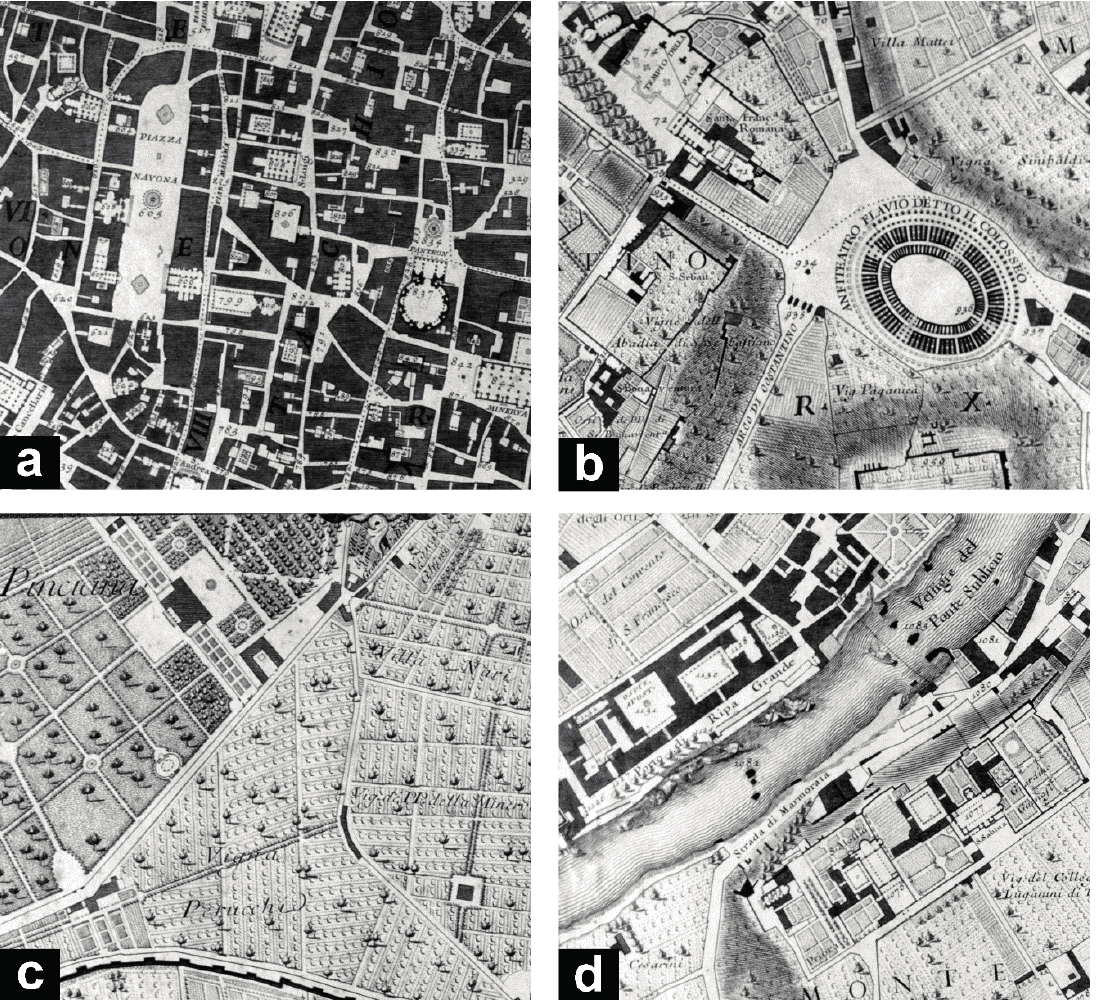
Figure 2. Details of the map: ( a ) building blocks; ( b ) archaeology; ( c ) open spaces; ( d ) pictorial